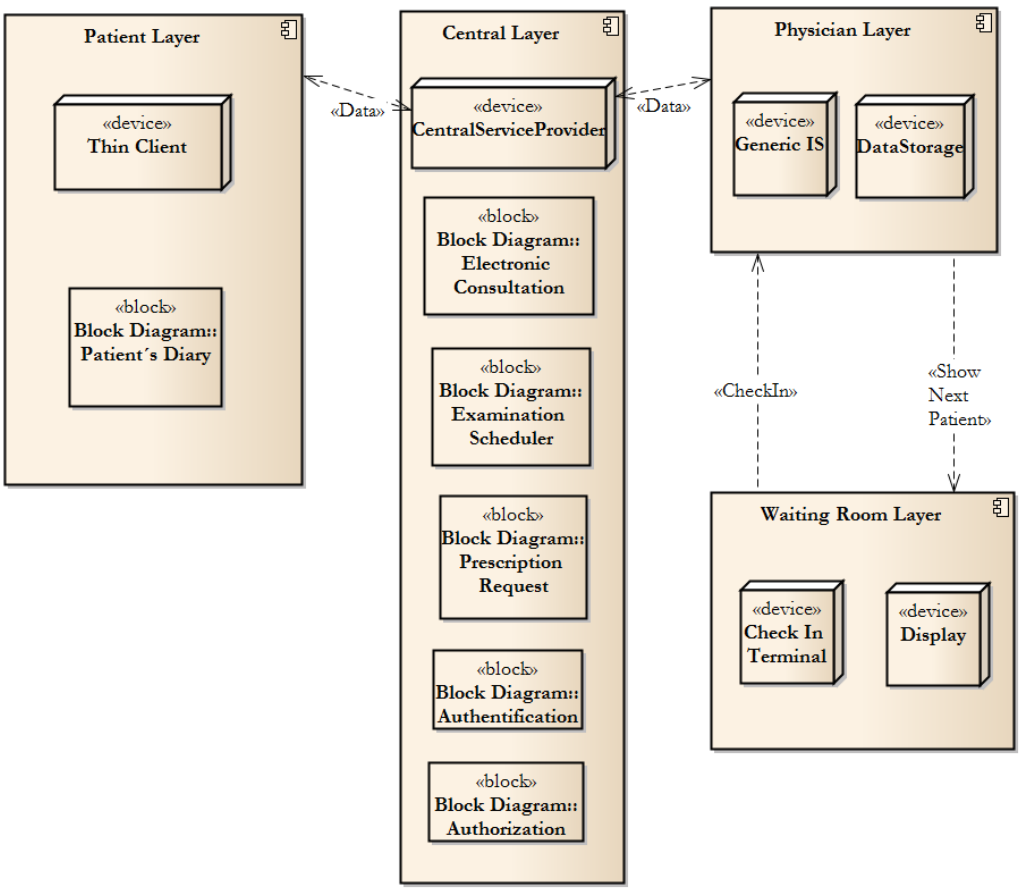
Figure 3. System